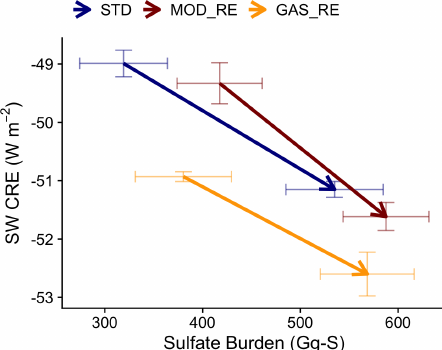
Figure 13. PI-to-PD changes in the SW CRE and sulfate burden of simulations in this study. [STD] (blue) refers to the simulation with model default chemistry. [MOD_RE] (dark red) denote the cases with our expanded DMS chemistry implemented with all gas-phase, aerosol-phase, and in-cloud reactions. [GAS_RE] (yellow), which only includes the expanded gas-phase reactions, is also shown. Ar- rows indicate changes from PI (tails) to PD (heads). Horizontal and vertical error bars span the 1 σ variabilities in the burden and SW CRE in the simulations,